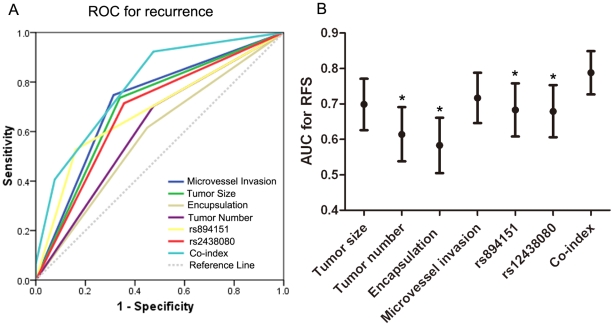
The predictive ability of the co-index of rs894151 and rs12438080 compared with single markers and other clinical prognostic parameters by receiver operating characteristic (ROC) curves (A).The areas under the curve (AUCs) with 95% CI are shown in B (*p<.05, compared with the co-index). The details for AUC and 95% CI are also shown in Table S7.